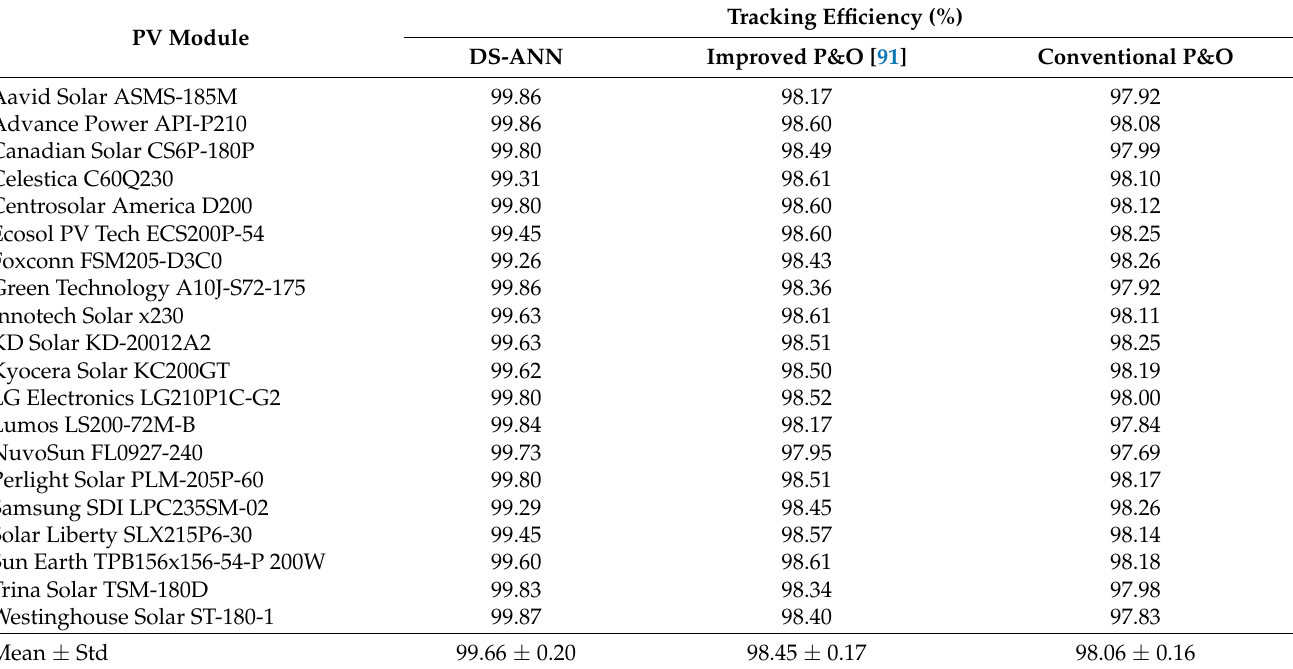
Table 2. Performance comparison of the different MPPT techniques for the case study.